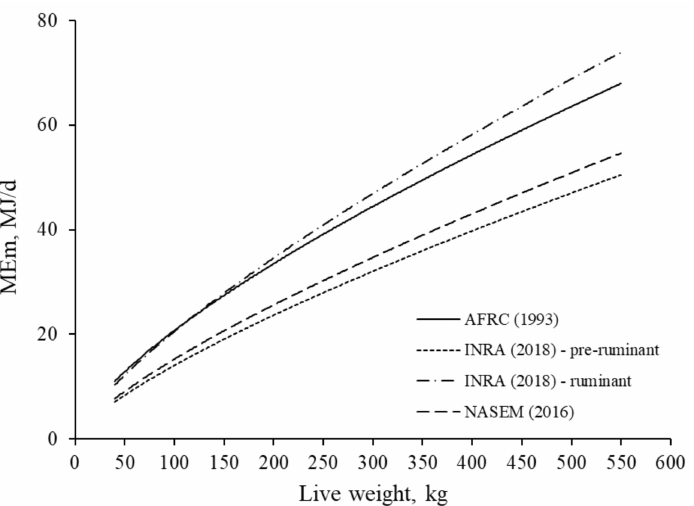
Figure 1. The relationships between LW and energy requirement for maintenance calculated for growing Bos taurus bulls according to equations by AFRC [2], INRA [5], and NASEM [13]. For comparison purposes among energy systems, a constant k m value was assumed to be equal to